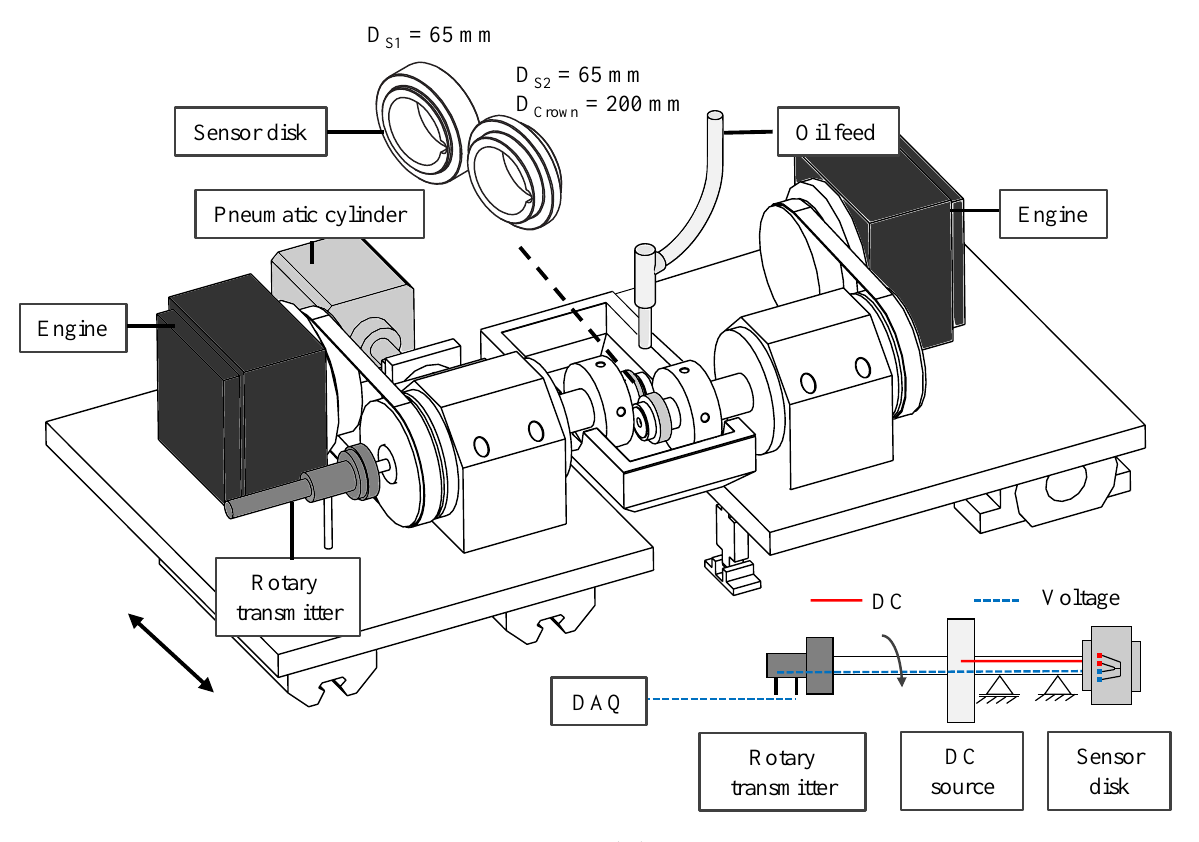
Figure 1. Two-disk test rig.